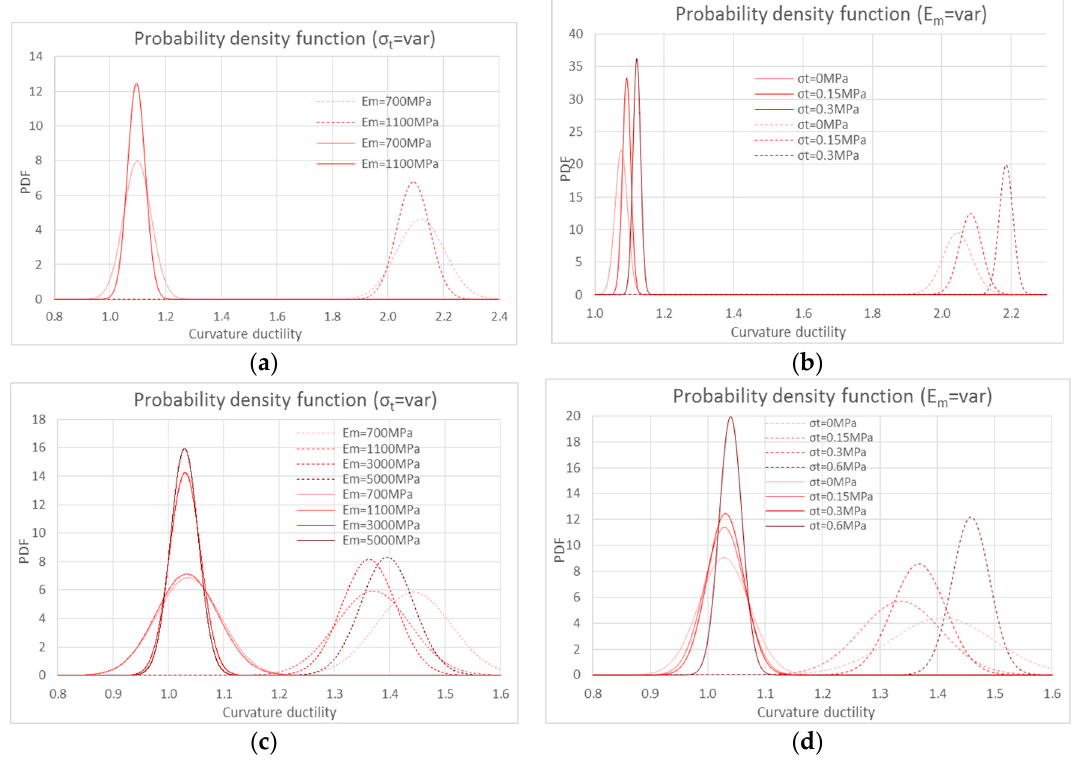
Figure 15. Probability density functions: ( a , c ) curvature ductility at different tensile strengths of masonry; ( b , d ) curvature ductility at different Young’s moduli, for the two stress-strain relationships for basalt fiber: linear (solid lines) and bi-linear (dotted lines). ( a , b ) on weak masonry ( σ 0 = 1 MPa) and ( c , d ) with σ 0 = 8 MPa.